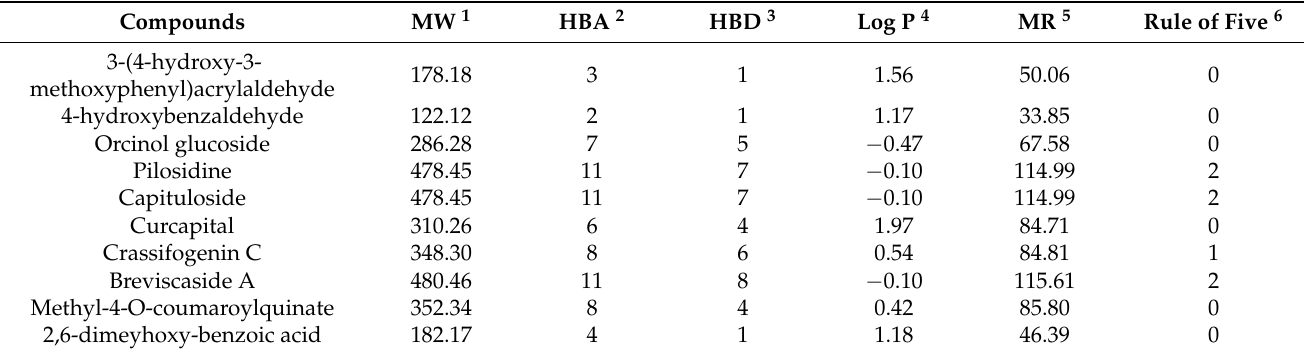
Table 5. ADME property prediction for the major selected bioactive compounds of M. capitulata , obtained using Swiss ADME online tool